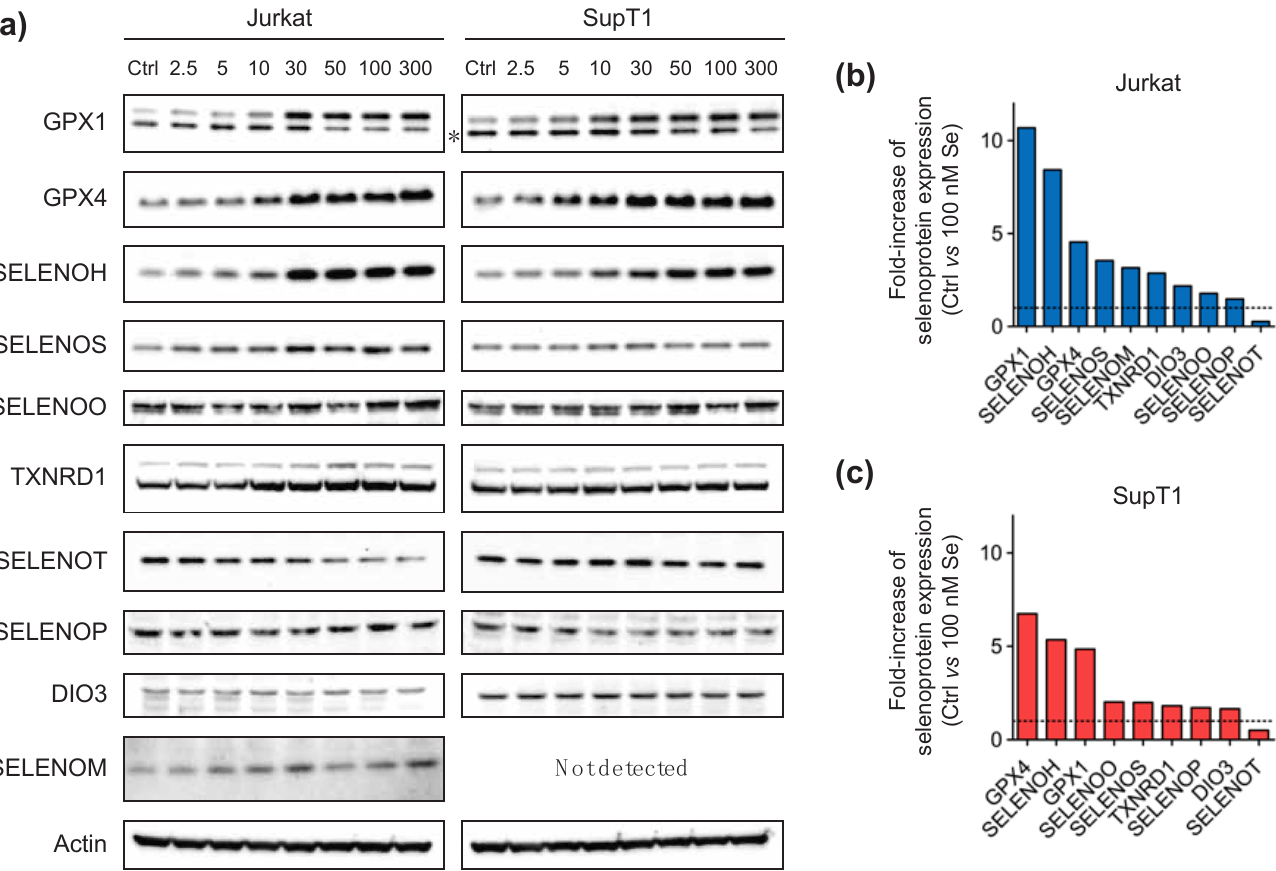
Figure 4. Analysis of selenoprotein expression in Jurkat and SupT1 cells in response to different selenium supplementations of the culture media (in nM) after three days. The results from a representative experiment are shown in ( a ). The values are given in Table S4. The fold-increase in expression of each selenoprotein in response to selenium supplementation was calculated between the value at 100 nM over that at Ctrl. These ratios were plotted from the highest to the lowest for Jurkat ( b ) and SupT1 ( c ) cells. The dotted line represents a fold-increase value of